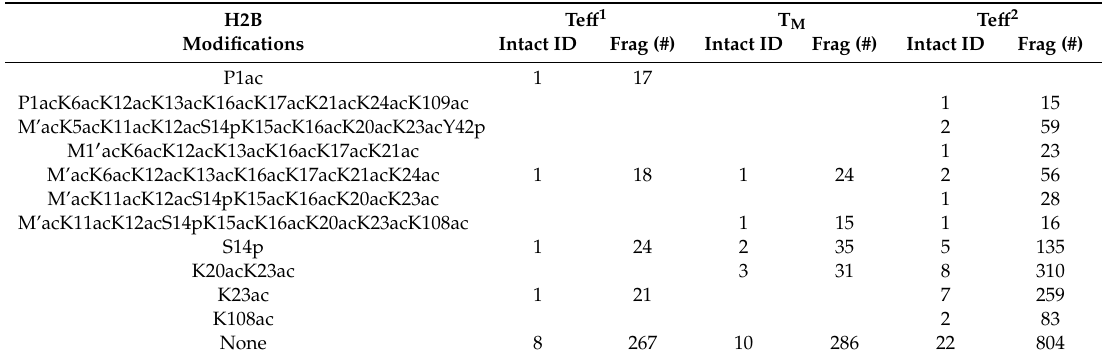
Table 3. H2B modifications from Te ff 1 , T M , and Te ff 2 after influenza infection. H2B Te ff